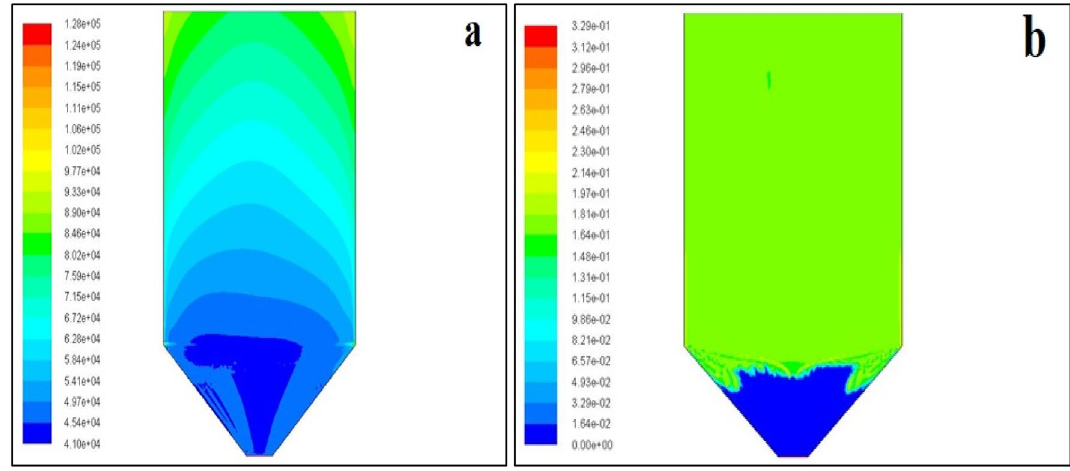
Figure 5. ( a ) Total pressure contours, ( b ) discrete phase